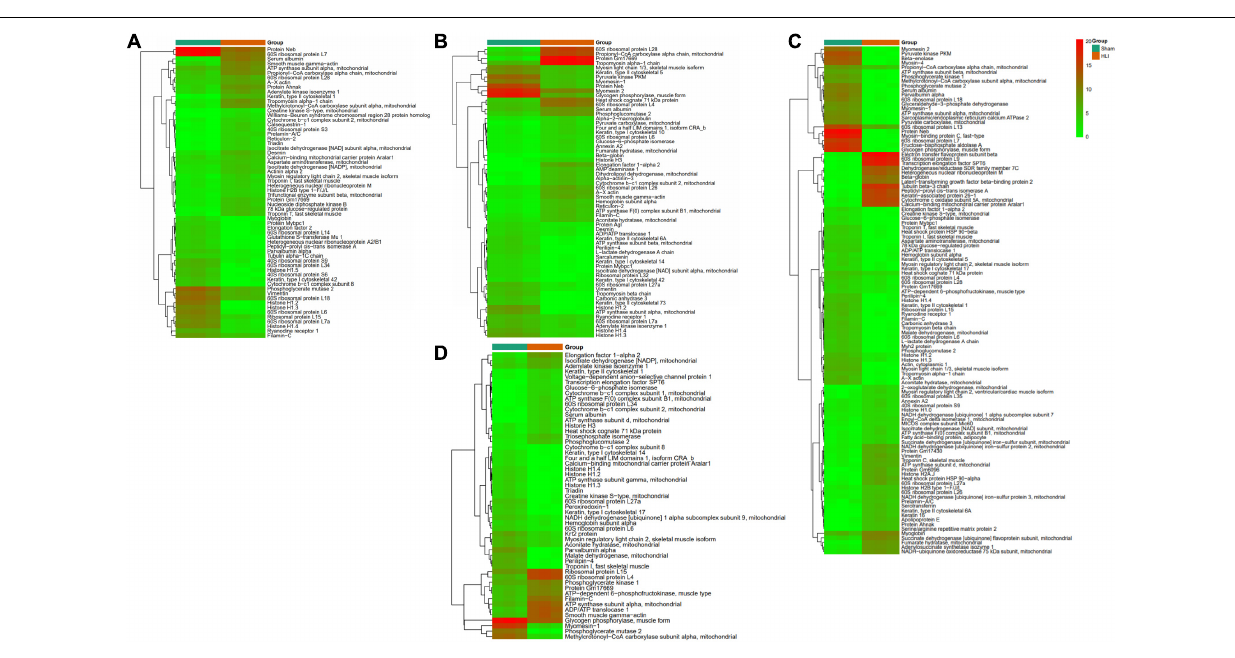
FIGURE 6 | Heat map showing the differentially expressed proteins at each time points. The heat map shows the differentially expressed proteins at days 1 (A) , 3 (B) , 7 (C) , and 14 (D). Each row represents a differentially expressed protein and each column, sample replicate. The color scale illustrates the relative level of differentially expressed protein expression: red, higher than the reference channel; green, lower than the